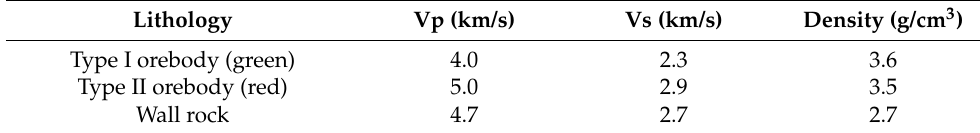
Table 2. Rock properties used in models D and